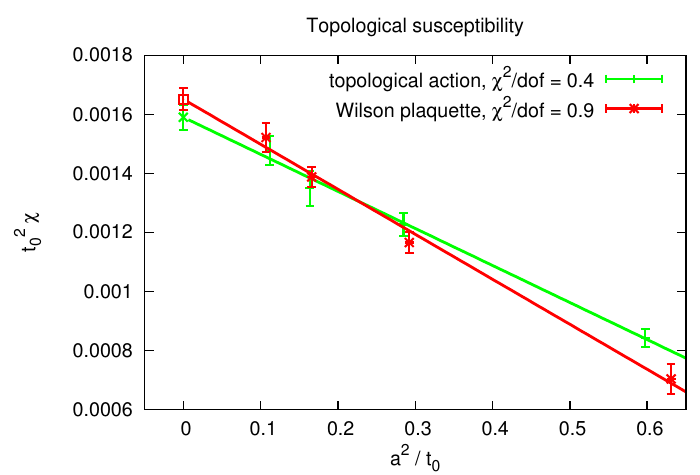
Figure 1 . Continuum extrapolations of the topological